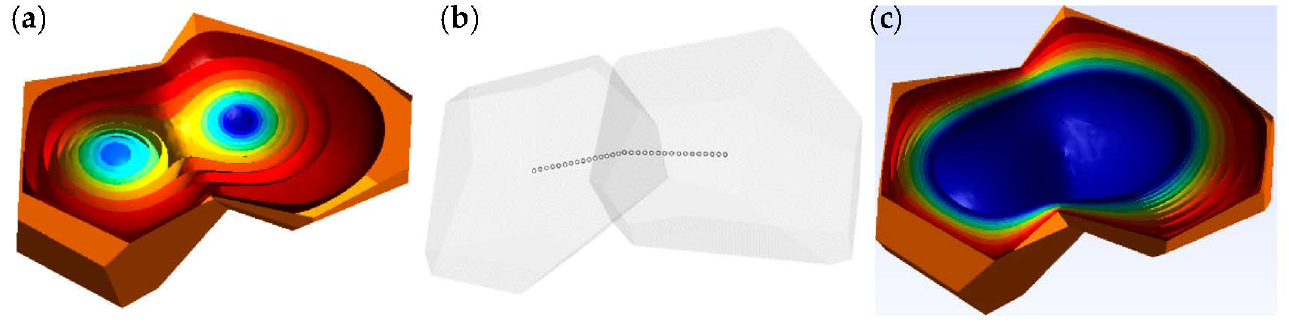
Figure 2. The construction of constraints for concave polyhedron. ( a ) is the concave surface and separate isothermal surfaces; ( b ) is generated centroids of a concave polyhedron from origin cen- troids and the common face; ( c ) is extracted isothermal surfaces using the EBC from ( b ).